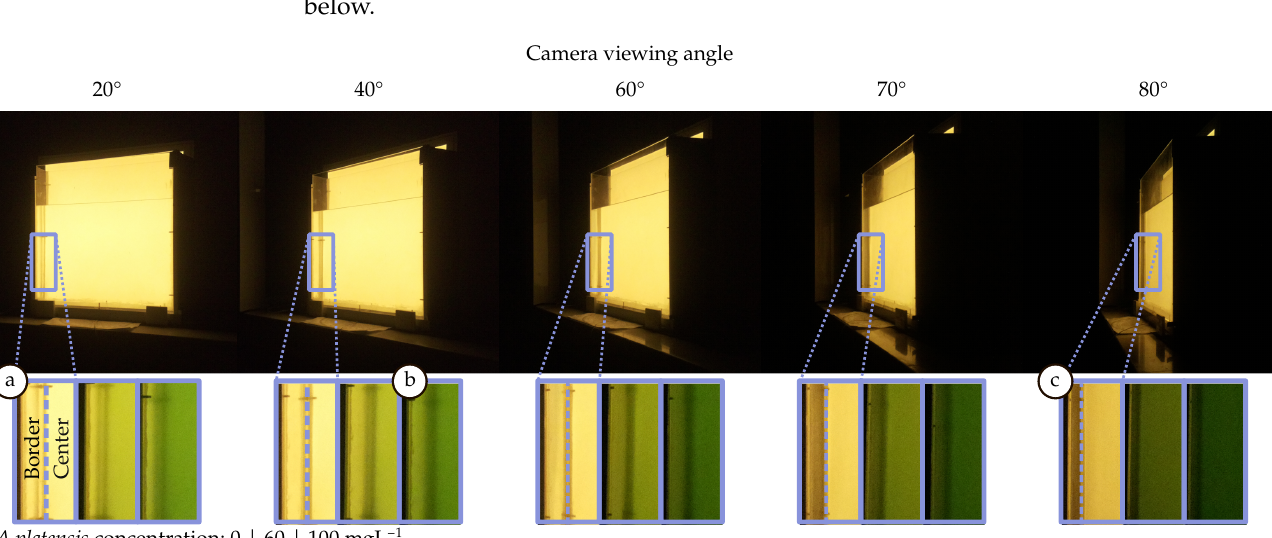
Figure 8. Red, green and blue radiation diagram of small areas located at the centre and the border of the container. To better illustrate how the camera perceives the differences in the radiation between both regions (centre and border) at a certain angle and to understand the reason behind selecting these two regions for the analysis, Figure 9 shows some examples of the images captured during this experiment. In this figure, framed in a blue rectangle, the interface that abruptly separates the centre and the border region is highlighted (Figure 9a). Furthermore, this region’s evolution with respect to the increase in concentration is shown in the boxes below.